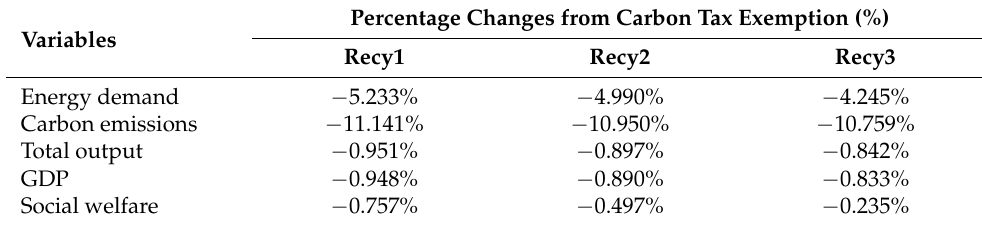
Table 3. Impacts of different scenarios on macroeconomy and social